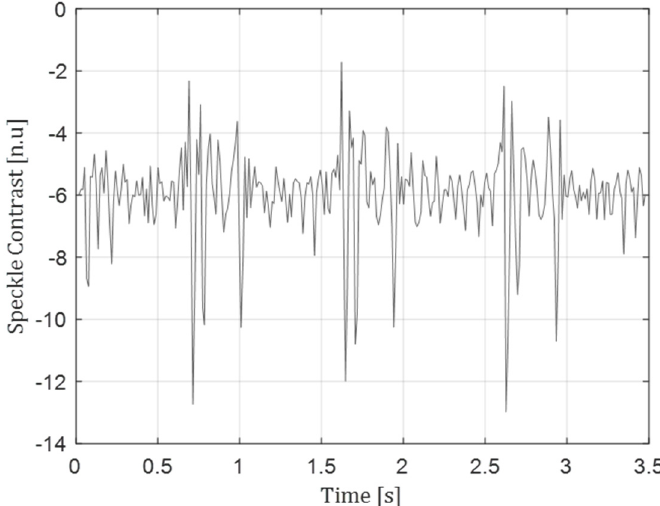
Figure 5. Chest movement signal reconstruction.